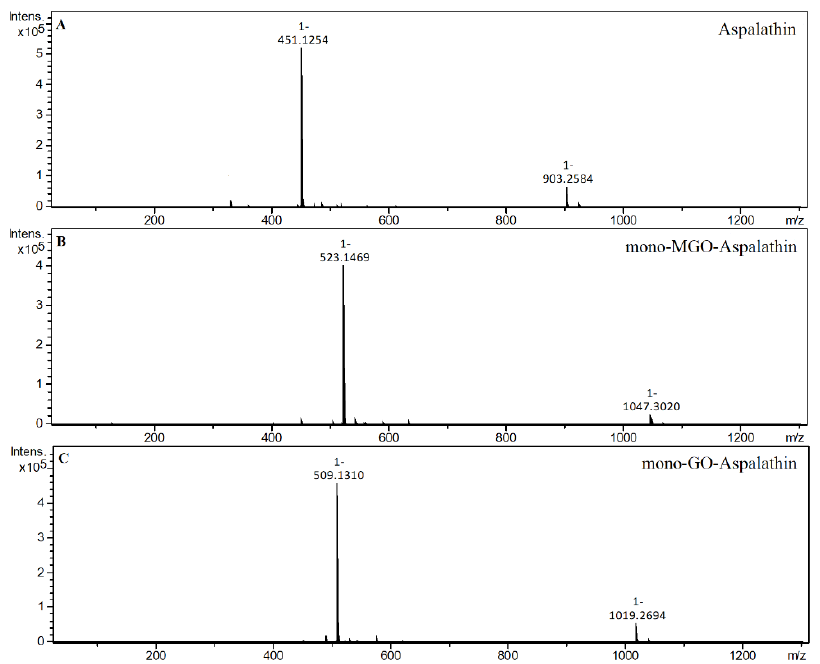
Figure 6. Mass spectra of aspalathin and its methylglyoxal/glyoxal adducts after 1 h of incubation in pH 7.4 phosphate buffer solution at 37 °C; ( A ), aspalathin; ( B ), mono-MGO-aspalathin; ( C ), mono- GO-aspalathin.